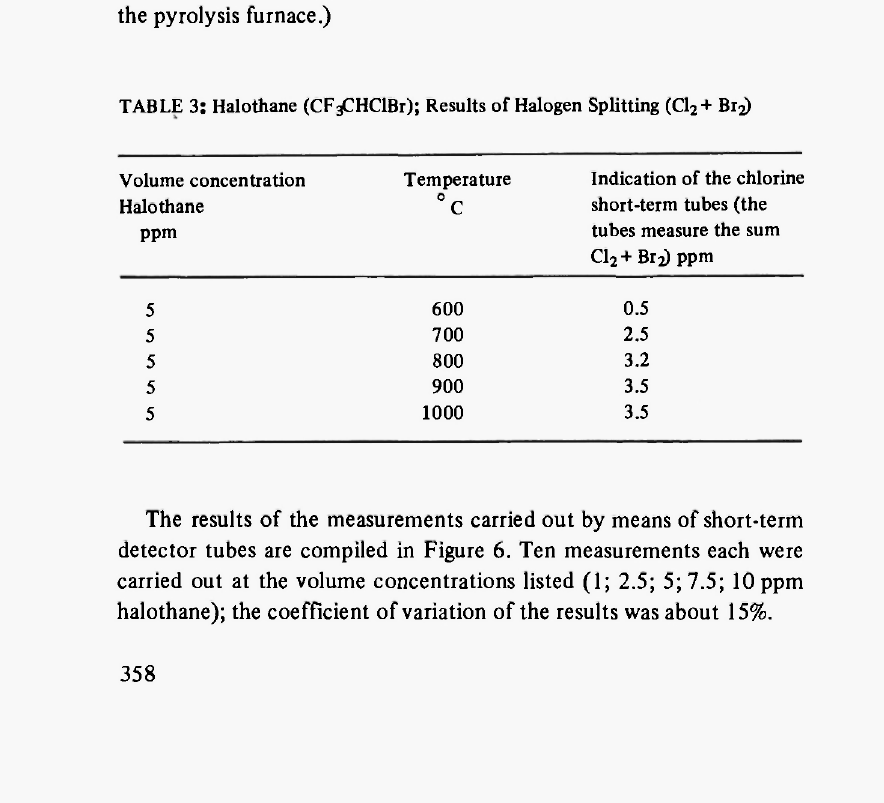
TABLE 3: Halothane (CFjCHClBr); Results of Halogen Splitting (Cl 2 + Br^